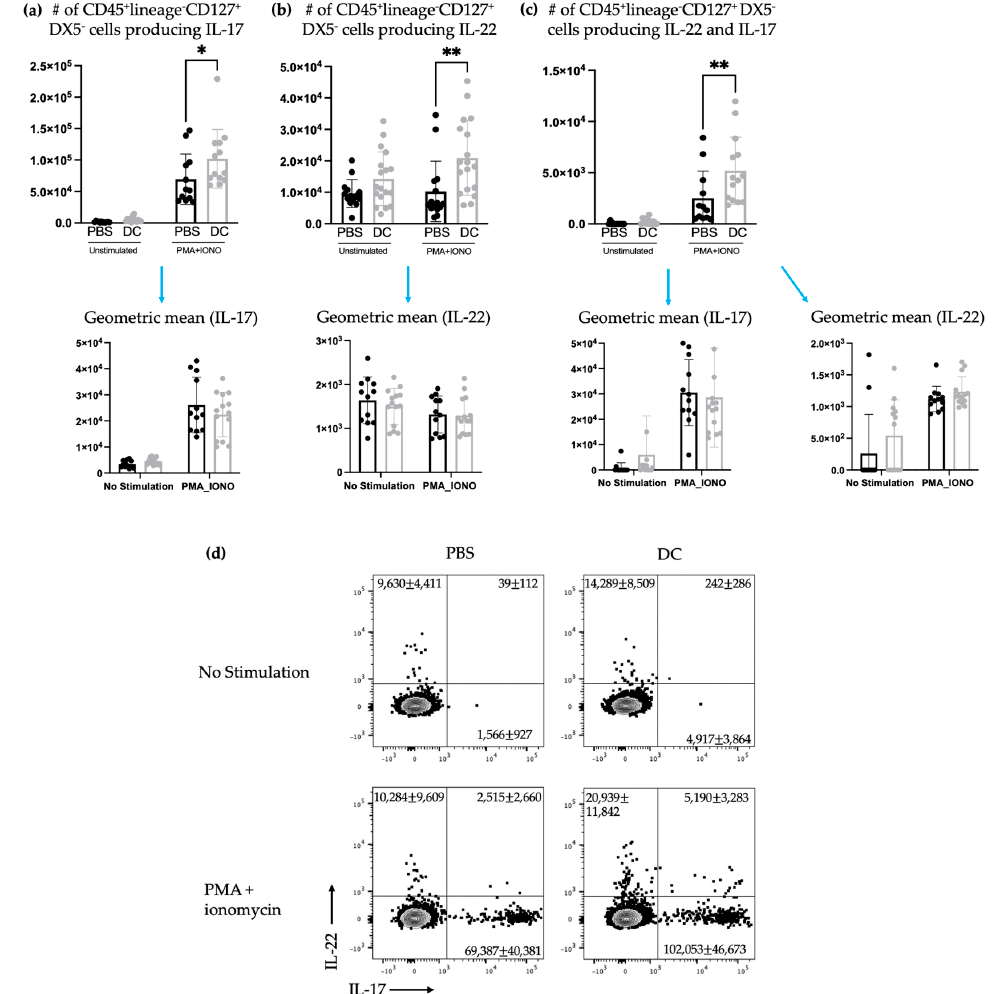
Figure 3. There was an increase in splenic ILC3s producing IL-17 and IL-22 following DC immu- nization. Female C57BL/6 mice ( n = 12–18) were inoculated with DC vaccines via hind footpad injection. The control mice were treated with phosphate-buffered saline (PBS). One week after immu- nization, spleens were harvested and examined for IL-17- and IL-22-producing ILCs. The number of lineage − CD127 + DX5 − cells producing ( a ) IL-17, ( b ) IL-22, and ( c ) both IL-17 and IL-22 and their corre- sponding geometric mean fluorescent intensities was determined using intracellular cytokine staining and flow cytometry. Data were analyzed using a two-way ANOVA test ( p -values * < 0.05, ** < 0.005). ( d ) Representative dot plots show the average number of splenic CD45 + lineage − CD127 + DX5 − cells producing IL-17 and/or IL-22. The graphs display the mean with the standard deviation.